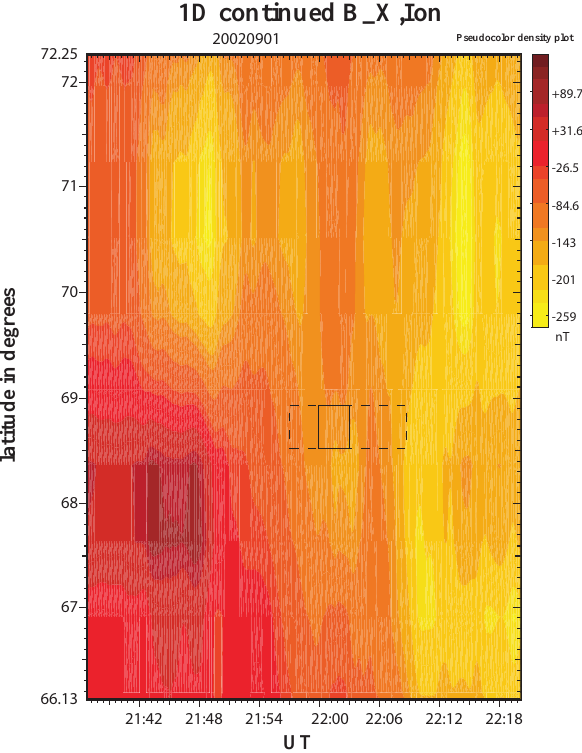
Fig. 7. One-dimensional upward field continuation of the X compo- nent of the magnetic field to the ionosphere performed for the north- south IMAGE magnetometer chain. Here the color code shows the east-west equivalent current (westward equivalent current expressed in negative values in nT). The black rectangle shows the time of the disturbance and footpoint area of the Cluster. The solid rectangle shows the interval of the flow disturbance at Cluster, and together with the dashed rectangles, present the interval of the entire current sheet disturbance at